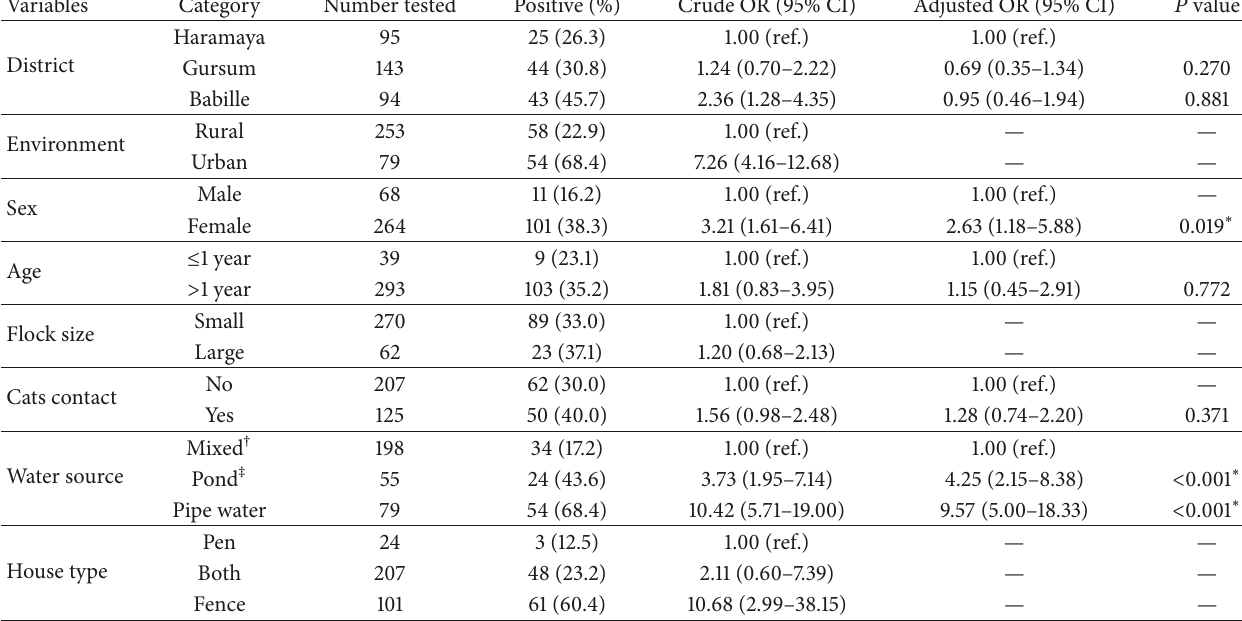
Table 2: Analysis of risk factors related to T. gondii seropositivity in sheep at animal level ( 𝑛 = 332